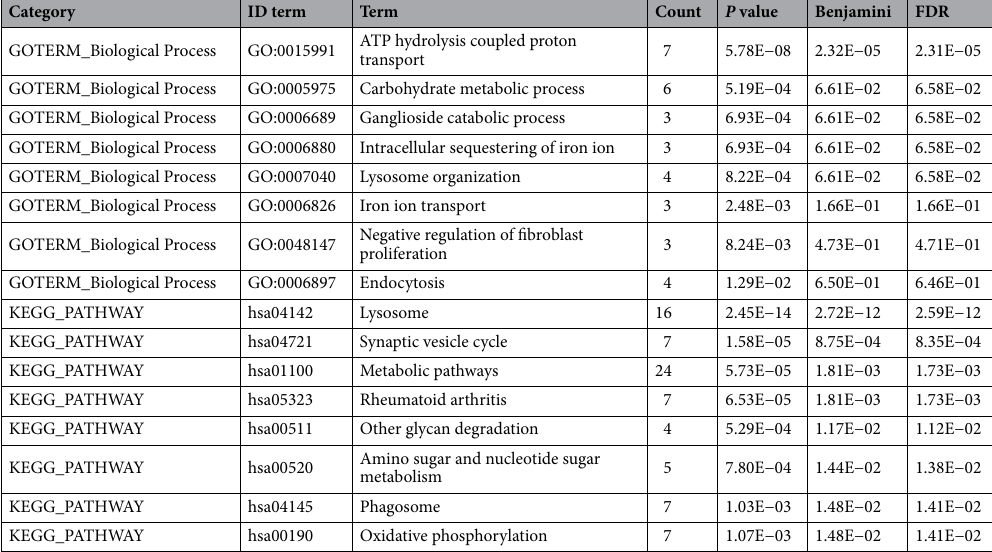
Table 5. The main GO and KEGG pathway enrichment analysis for 117 co-expressed